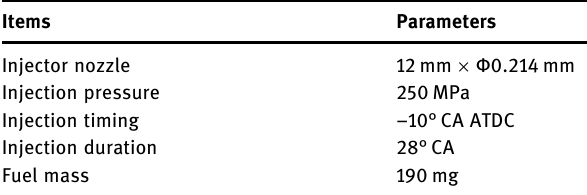
Table 3: Parameters of the injector